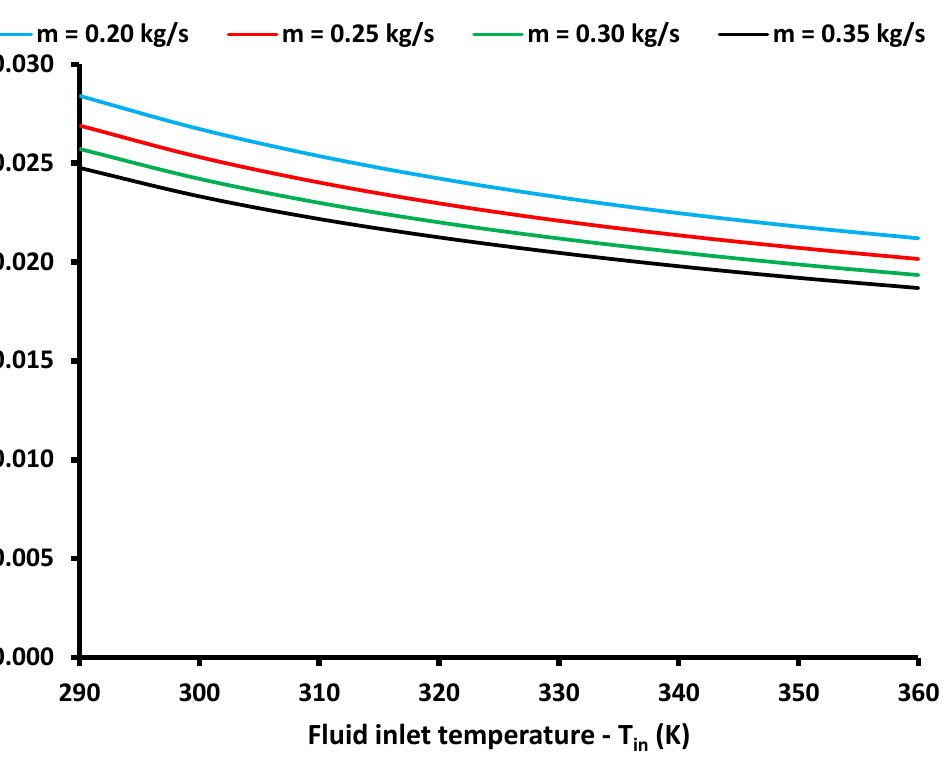
Figure 9. Friction factor variation for the different operating scenarios in the reference case of the empty tube.